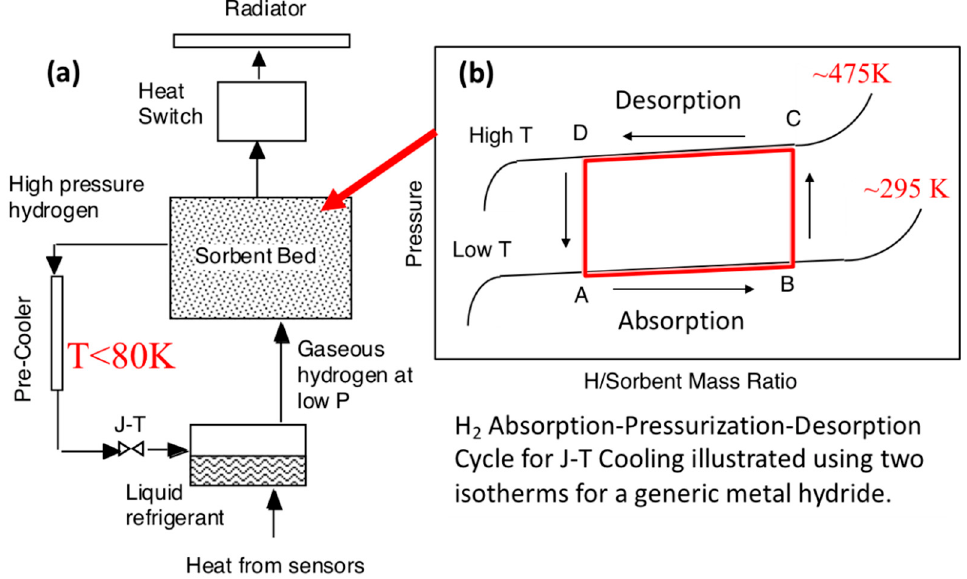
Figure 1. ( a ) Schematic diagram of a single-stage sorption cryocooler with a metal hydride sorbent bed producing liquid hydrogen and ( b ) the idealized closed-loop cycle A–B–C–D that is superimposed on the isotherms for a representative metal hydride (Adapted from Figure 1 of Reference [5] (2019, with permission from Elsevier)) .